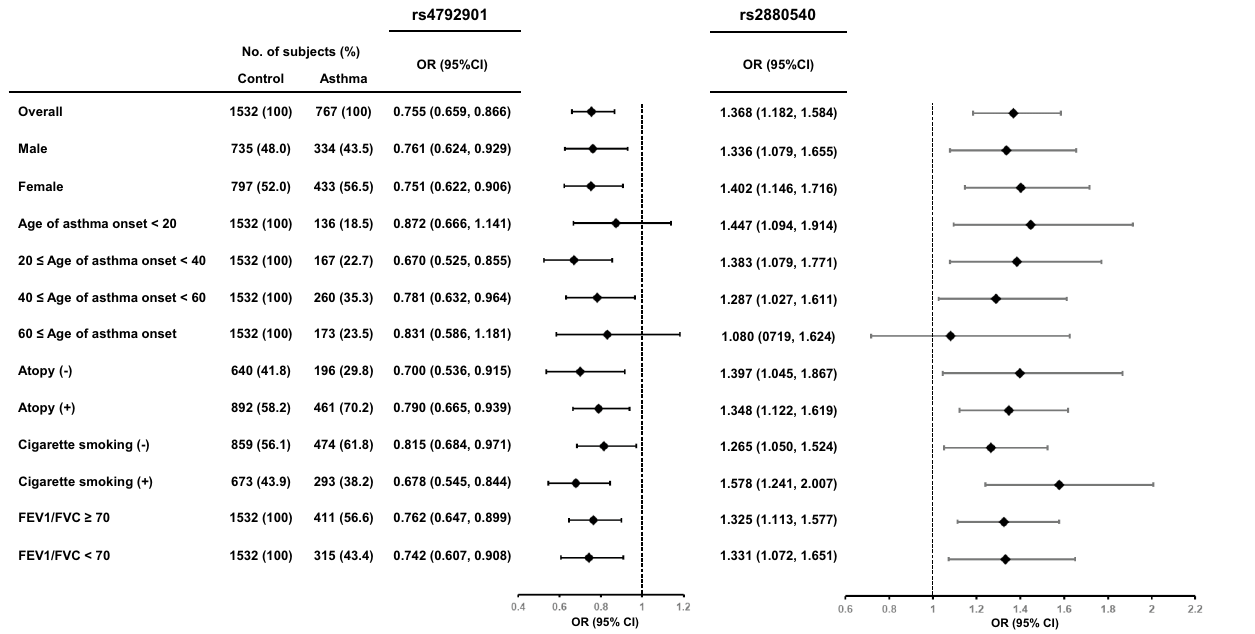
Figure 4. Stratified meta-analysis of association studies with asthma. Association of rs4792901 and rs2880540 with asthma was studied by logistic regression analysis based on an additive genetic model. The results were meta-analyzed using a random effects model. The width of the horizontal lines represents the 95 percent confidence intervals for each